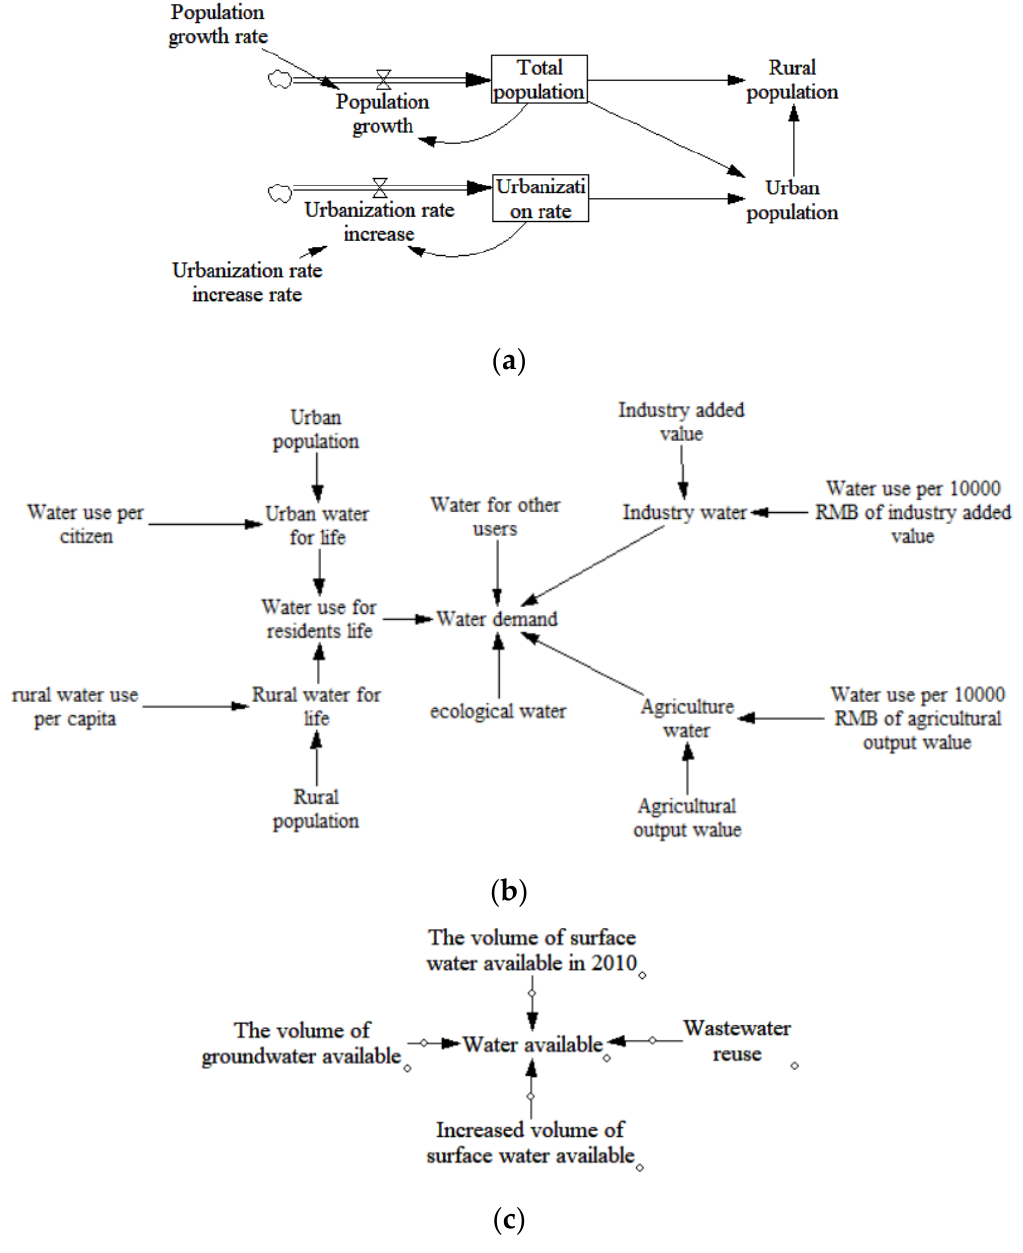
Figure 3. The flow diagram of main variables in the sub-model of WRCC: ( a ) total population, ( b ) water demand, ( c ) water available.